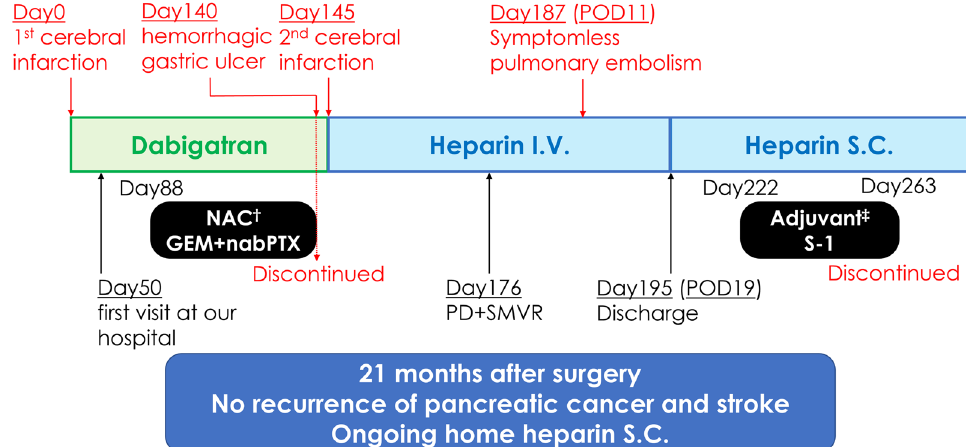
Fig. 3 Clinical course. † Ended in the middle of the second course. ‡ Ended after one course due to anorexia. GEM gemcitabine, I.V. intravenous injection, PTX paclitaxel, PD SMVR pancreatoduodenectomy with superior mesenteric vein resection, POD postoperative day, S.C. subcutaneous +